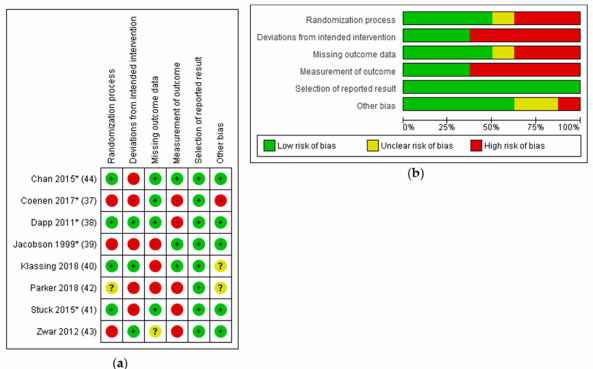
Figure 3. Risk of Bias assessment; ( a ) Risk of Bias summary; ( b ) Risk of Bias